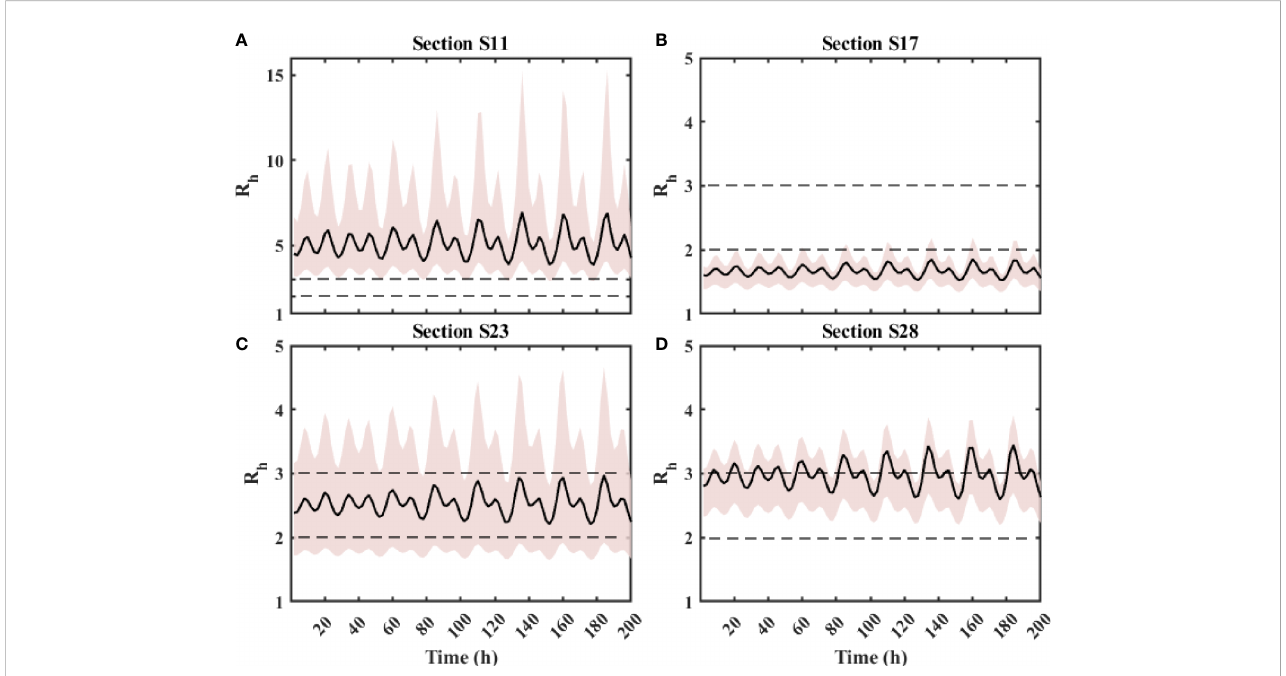
FIGURE 7 R h in time series of different sections: (A) S11, (B) S17, (C) S23, and (D) S28. The black lines in (B, C) stand for the R h calculated by average depth of fl oodplain. The red areas were bounded by the maximum and minimum R h calculated by minimum and maximum depths of the fl oodplains,